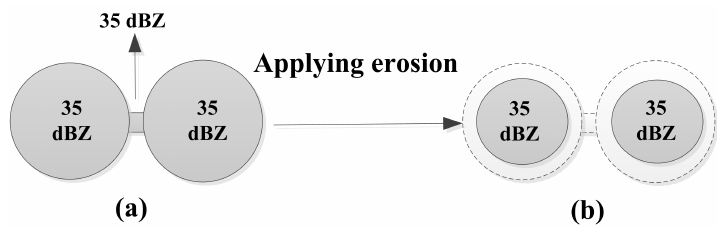
Figure 1. ( a ) False merger; ( b ) result of erosion.